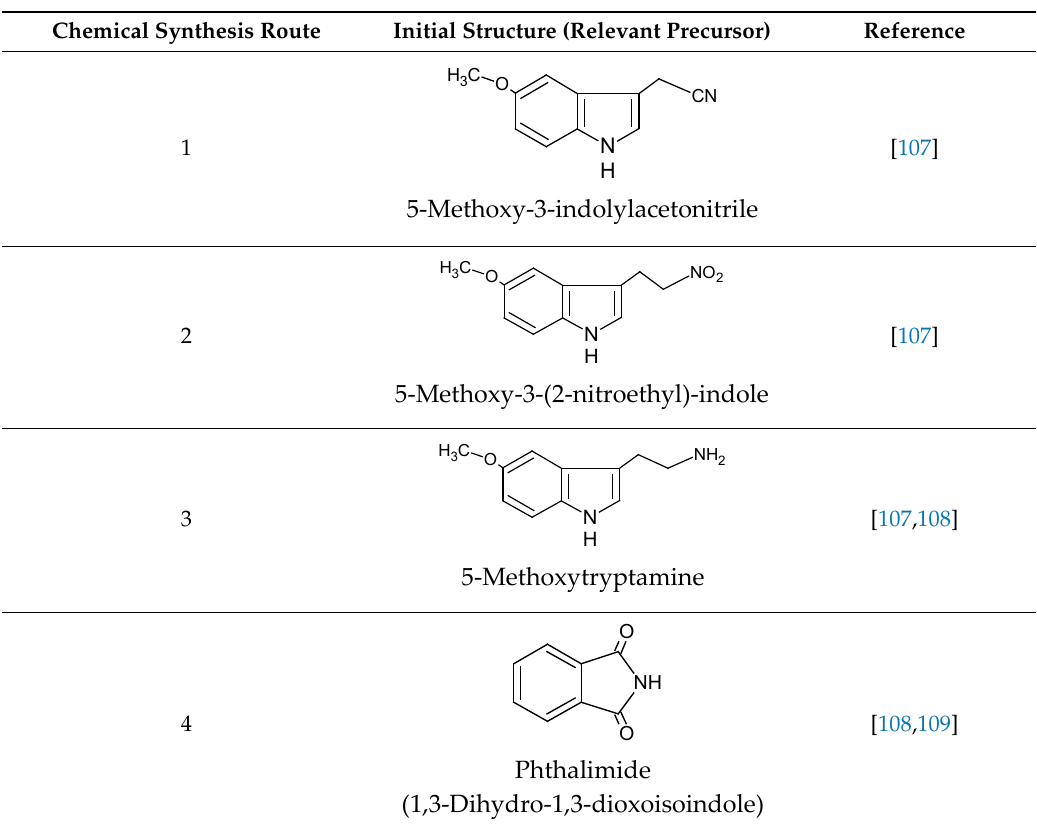
Table 3. Precursors in the different chemical synthesis routes of melatonin.